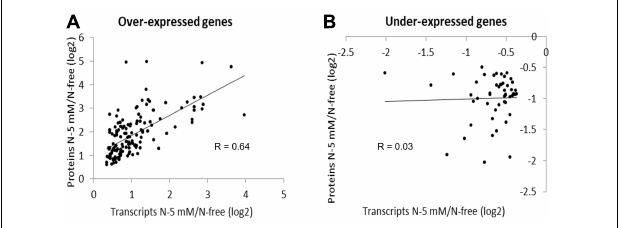
FIGURE 7 | Comparison of transcript and protein level fold-changes in response to nitrate for the 196 differentially expressed genes identified in R108 by their two products (transcript and protein). Log2 ratio of transcript level fold-changes were plotted as a function of the log2 ratio protein level fold-changes for the 143 over-expressed genes (A) and the 51 under-expressed genes (B)